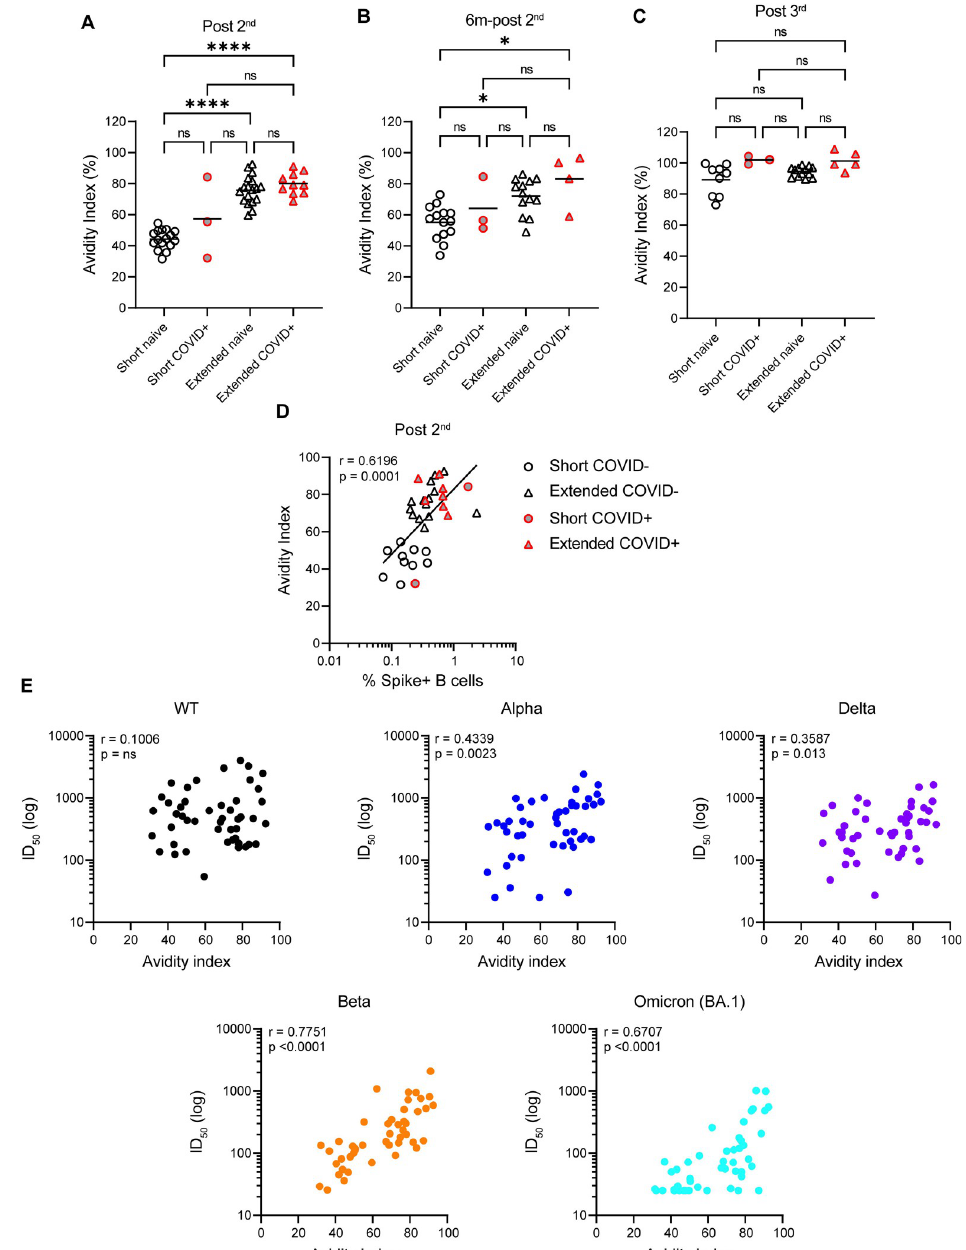
Fig 6. IgG binding avidity increases with vaccine boosting. Avidity index for IgG binding to Spike was measured A) post 2 nd , B) 6 months post 2 nd and C) post 3 rd and compared across groups. Avidity index was calculated by comparing the area under the curve (AUC) with/without an 8M Urea washing step. D’Agostino and Pearson tests were performed to determine normality. Based on this result, differences between groups were assessed using a Kruskal- Wallis test with Dunn’s multiple comparisons post hoc. D) Correlation between avidity index and % Spike-reactive memory B cells. (Spearman’s correlation, r ; a linear regression was used to calculate the goodness of fit, r 2 ). E) Correlations between avidity index and ID 50 against VOCs following 2-doses of BNT162b2 vaccine.